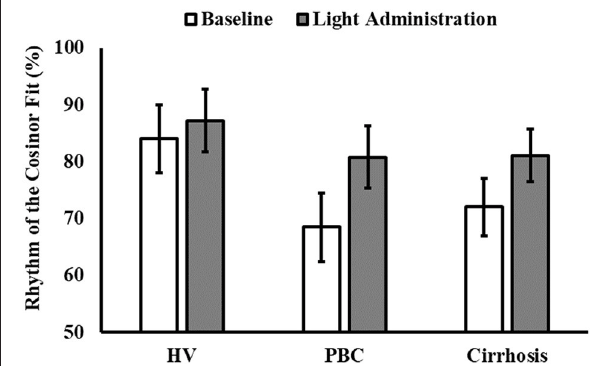
FIGURE 3 | Robustness of the 6-sulphatoxymelatonin (aMT6s) rhythm (i.e., percentage data variability accounted for by the cosine curve, % rhythm) before (white columns) and after light administration (gray columns), by patient category (HV, healthy volunteers; PBC, Primary Biliary Cholangitis). Patient category: p = 0.250; treatment: p = 0.035; patient category × treatment: p = 0.601.